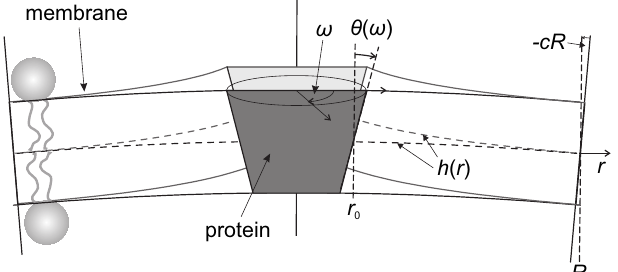
Figure 7. Schematic illustration of conical membrane-embedded rigid protein. For anisotropic proteins, the cone angle θ depends on the azimuthal angle ω . Adapted with permission from ref. [22]. 2006